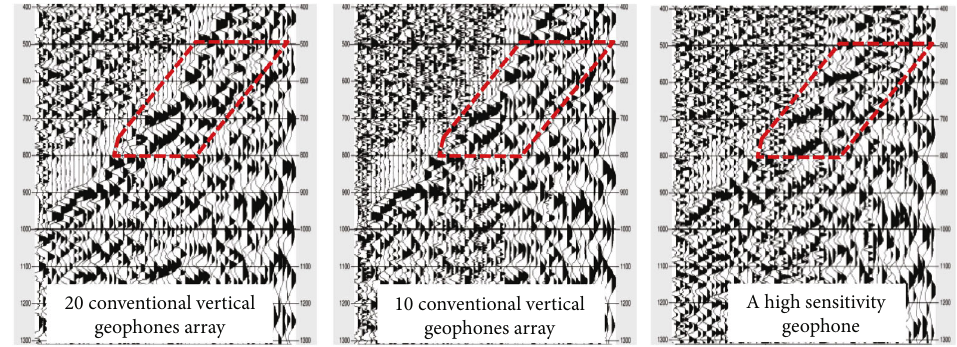
Figure 6: Shot records with di ff erent receiving